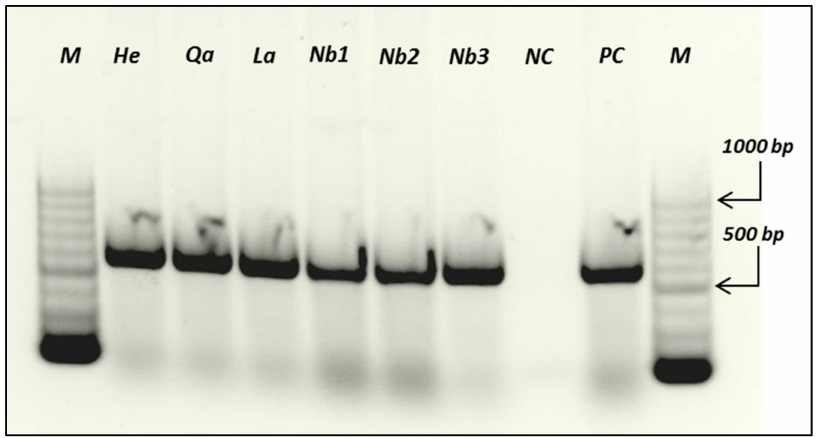
Figure 4. The 1.2% Agarose gel electrophoresis analysis of 562 bp of the PVX coat protein (CP) gene amplified by RT-PCR from three eggplant samples from (He): Hermel, (Qa): Qaa, (La): Labweh, and three mechanically inoculated Nicotiana benthamiana plants (Nb1–3); (NC) negative control, (PC) positive control and (M) marker GeneRuler 100 bp DNA Ladder (Thermo